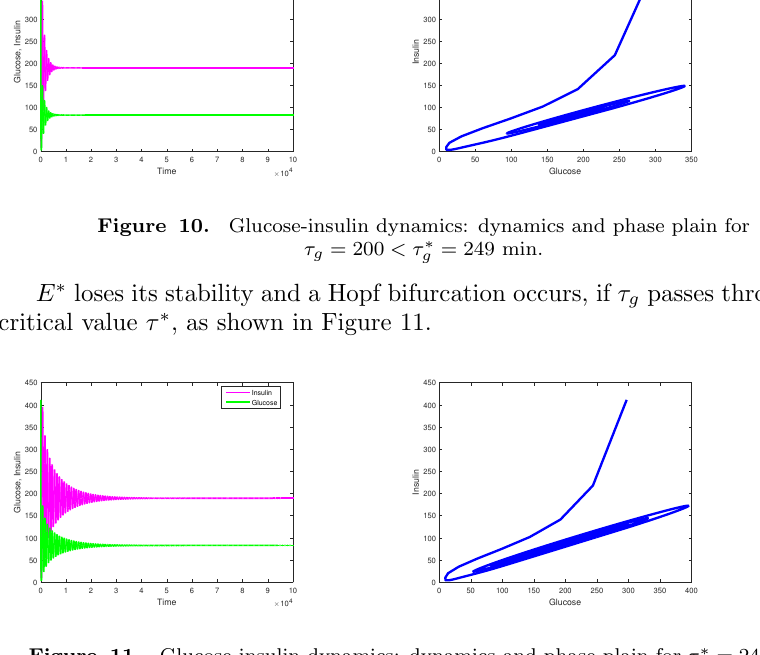
Figure 11. Glucose-insulin dynamics: dynamics and phase plain for τ ∗ g = 249 min.